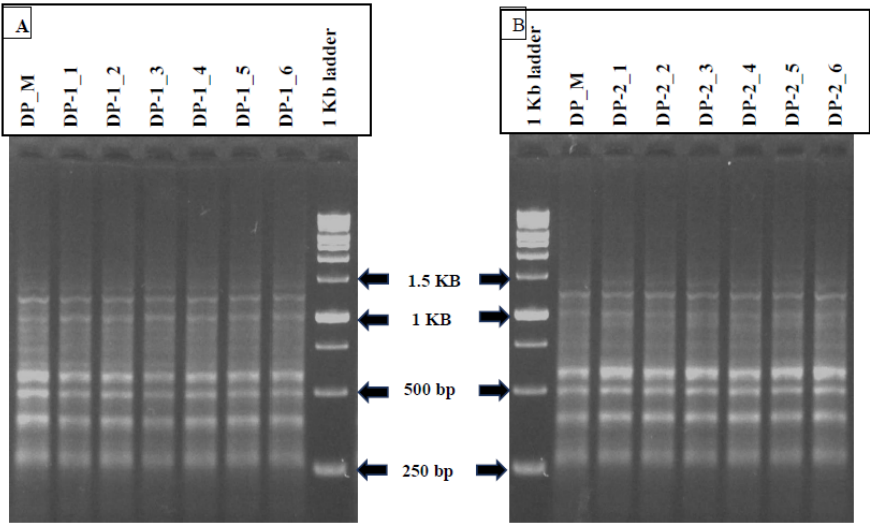
Figure 9. SCoT banding profiles of in vitro propagated plants with mother plant (DP_M) of D. purpurea with SCoT 14 primer. ( A ) DP-1_1 to DP-1_6 (somatic embryo-derived plants), ( B ) DP-2_1 to DP-2_6 (organogenic-derived plants).